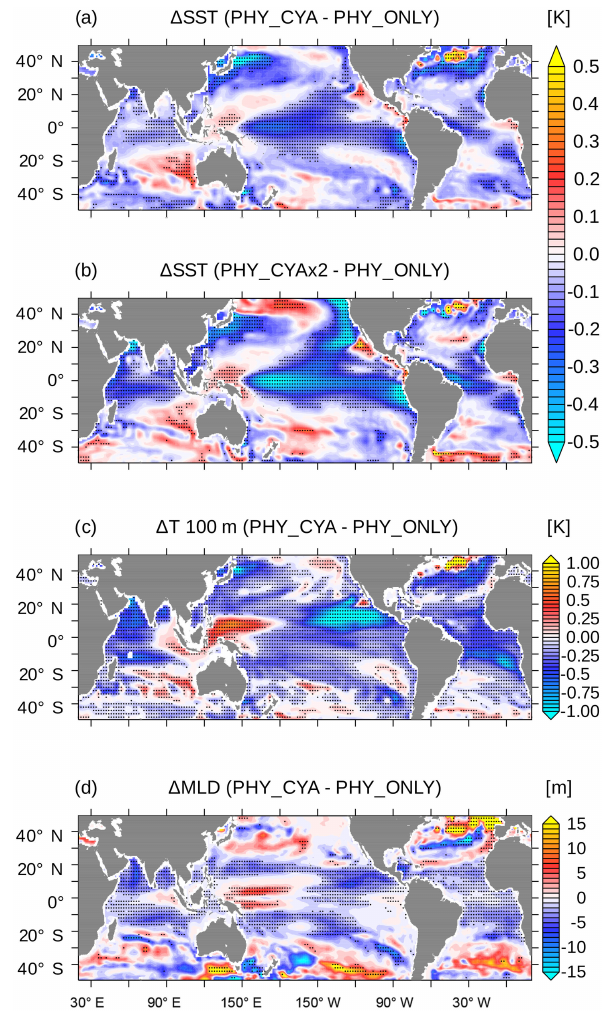
Figure 2. (a) Difference in the climatological annual mean SST (K) between PHY_CYA and PHY_ONLY and (b) between PHY_CYAx2 and PHY_ONLY. (c) Difference in the climatological annual mean temperature at a depth of 100m (K), and (d) MLD (m) between PHY_CYA and PHY_ONLY. Dotted areas indicate statis- tically significant anomalies at the 90% confidence level (student’s t